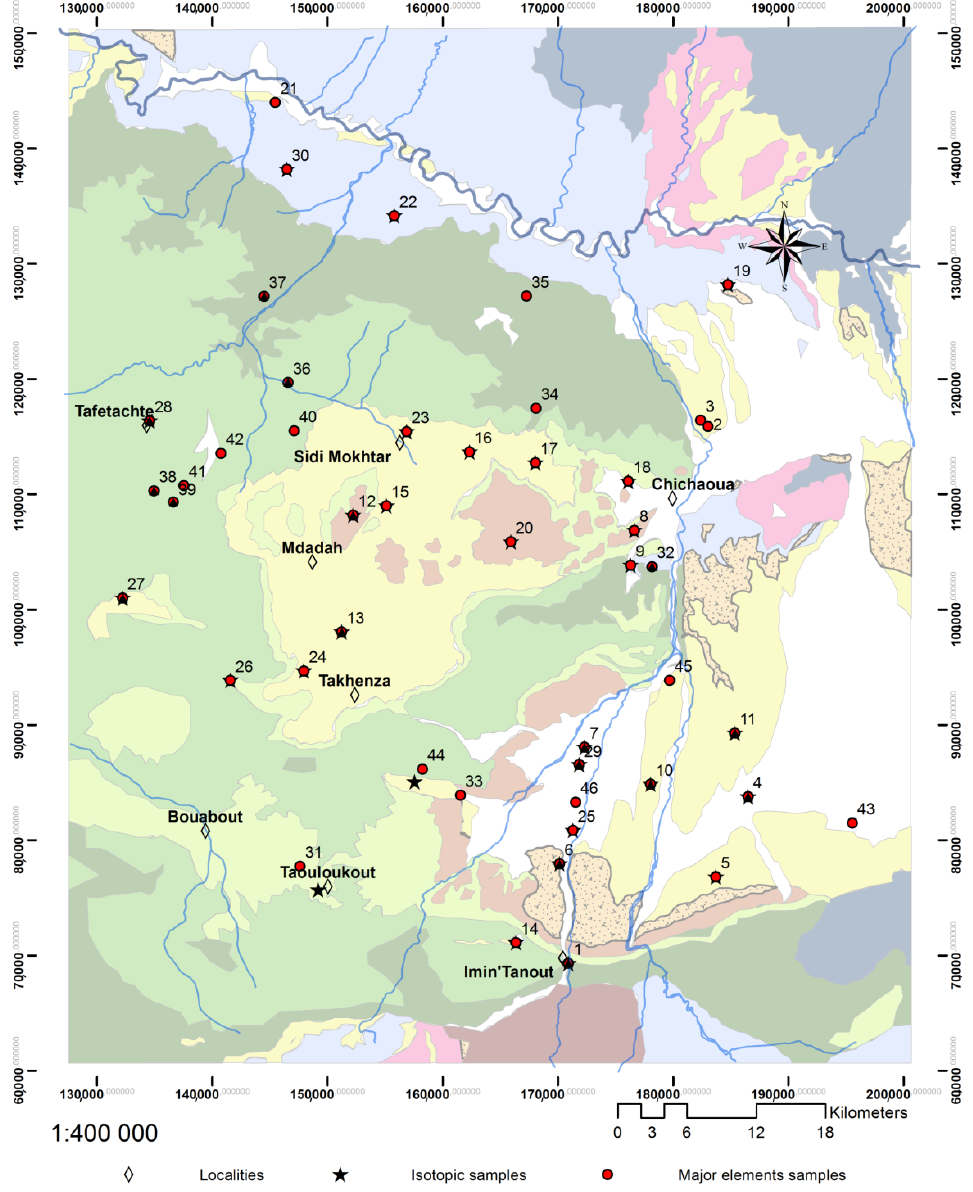
Figure 5. Location of hydrochemical and isotopic samples.